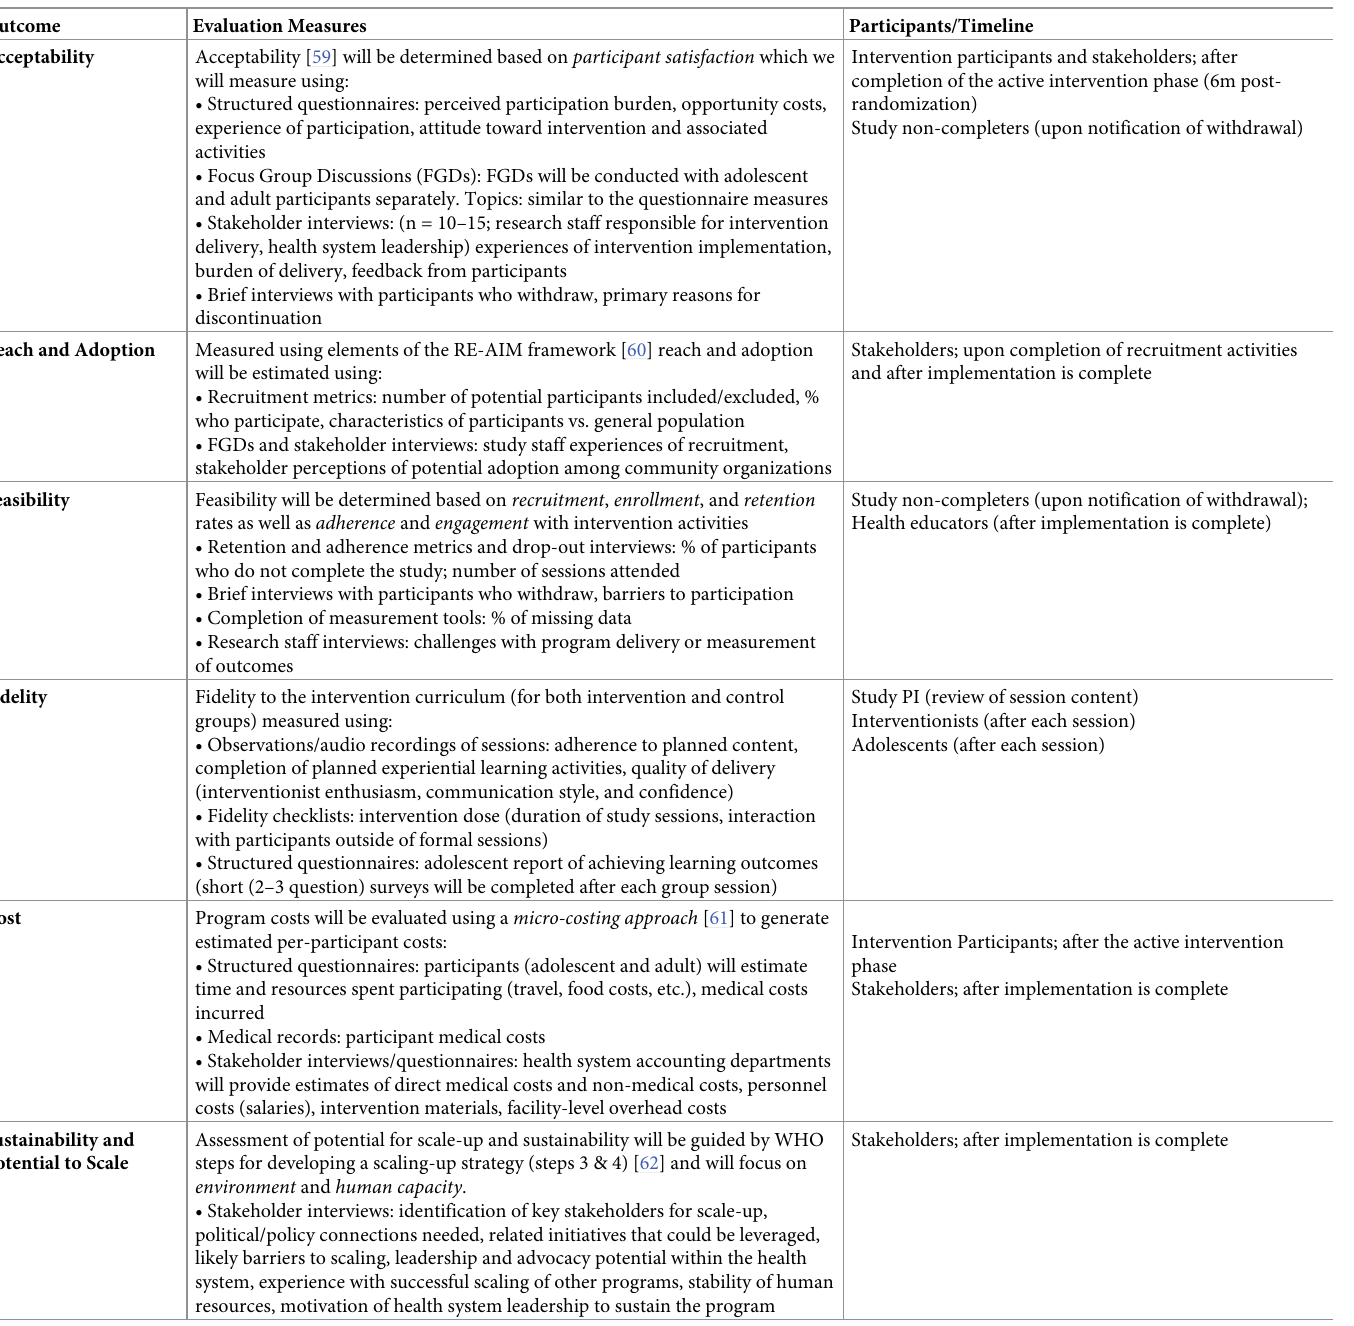
Table 3. Intervention evaluation